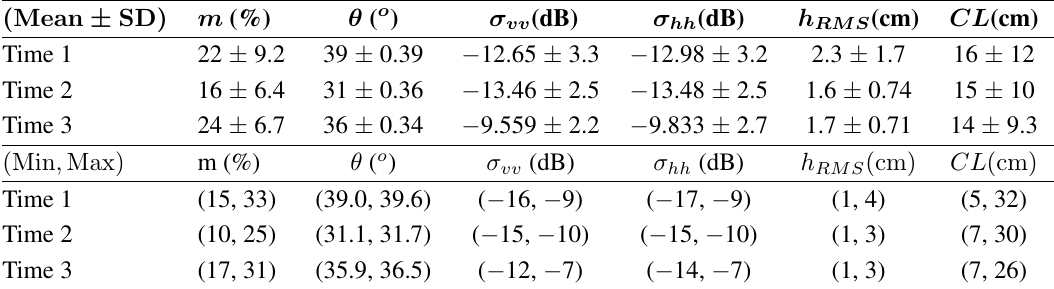
Table 2. In-situ measurement of volumetric soil moisture ( m ), incidence angle ( θ ), backscatter coefficents ( σ vv , σ hh ) (mean values are quoted to 4 significant figures to show standard deviation, SD) and surface roughness parameters ( h RMS and CL ) for the Casselman study region. Estimated 95% quantile ranges are also provided for each variables, for each day of observation: Time 1 (5 May), Time 2 (16 May), Time 3 (23 May), along with minimum and maximum